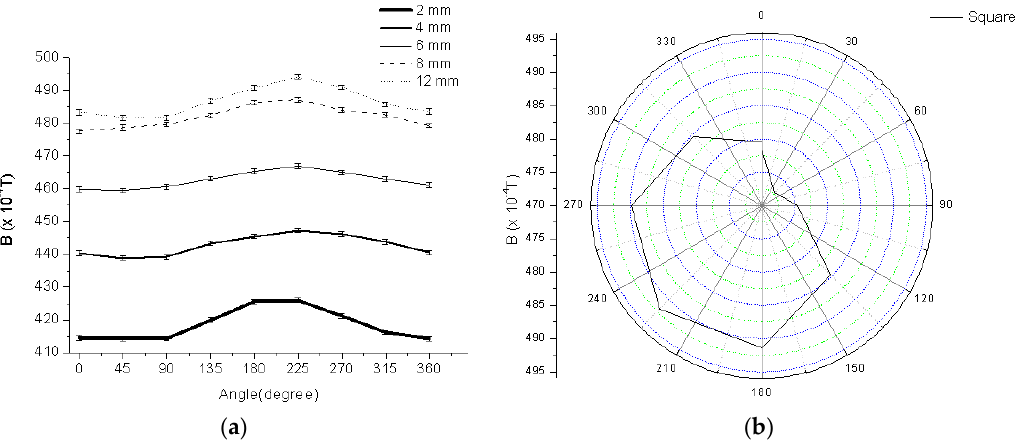
Figure 5. Changes found at the center of the samples with thicknesses of 2, 4, 6, 8, and 12 mm in the induced magnetic field versus the rotation angle ( a ); determination of the magnetic easy direction in a sample with a square shape (diagonal of 24 mm and thickness of 12 mm) ( b ).